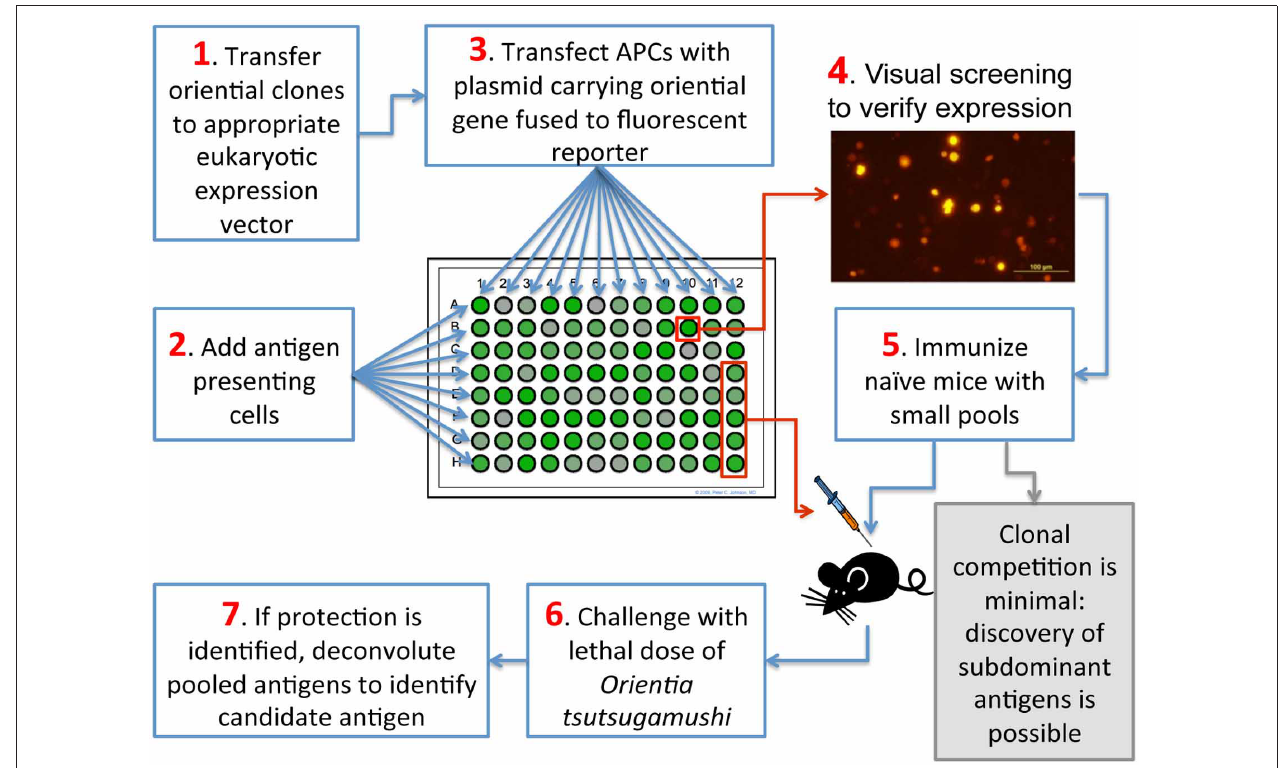
FIGURE 1 | Diagram of a strategy to discover subdominant antigens recognized by T cells.